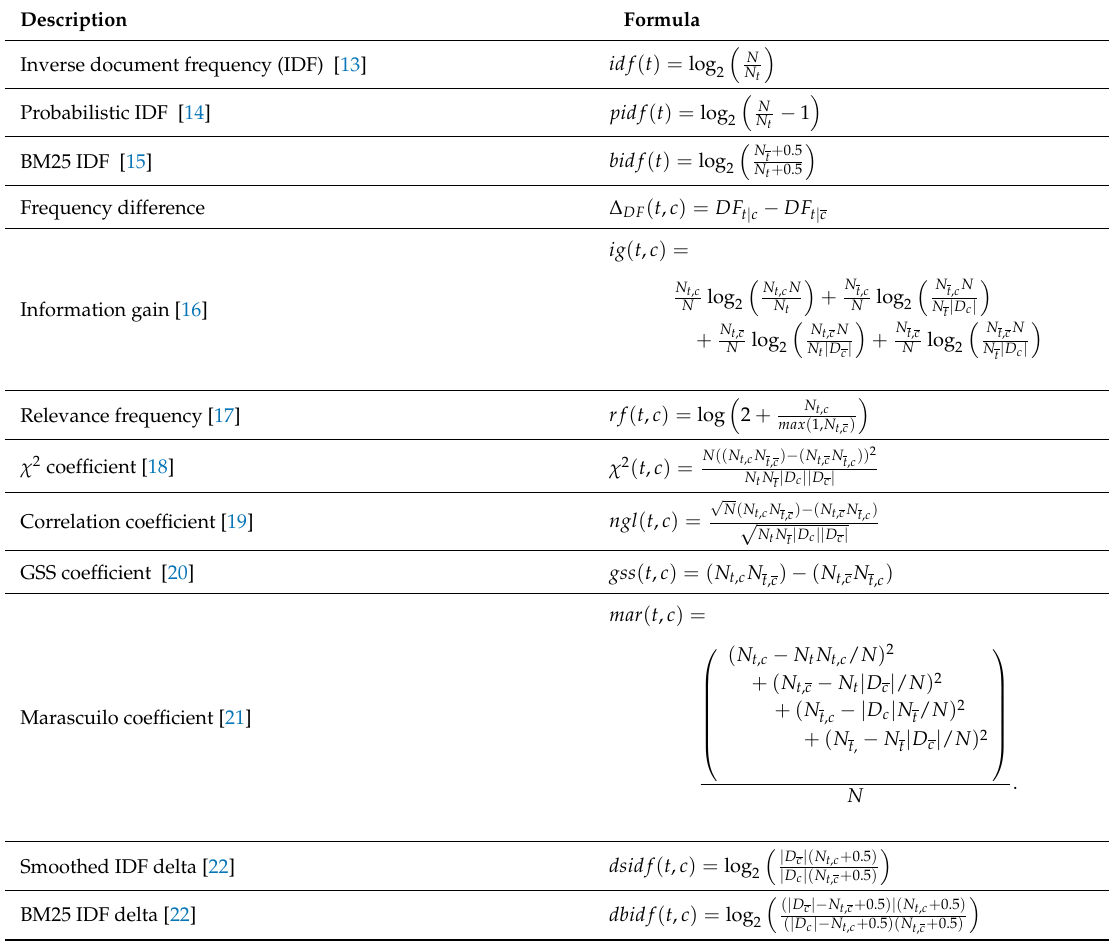
Table 5. Global weighting metrics.